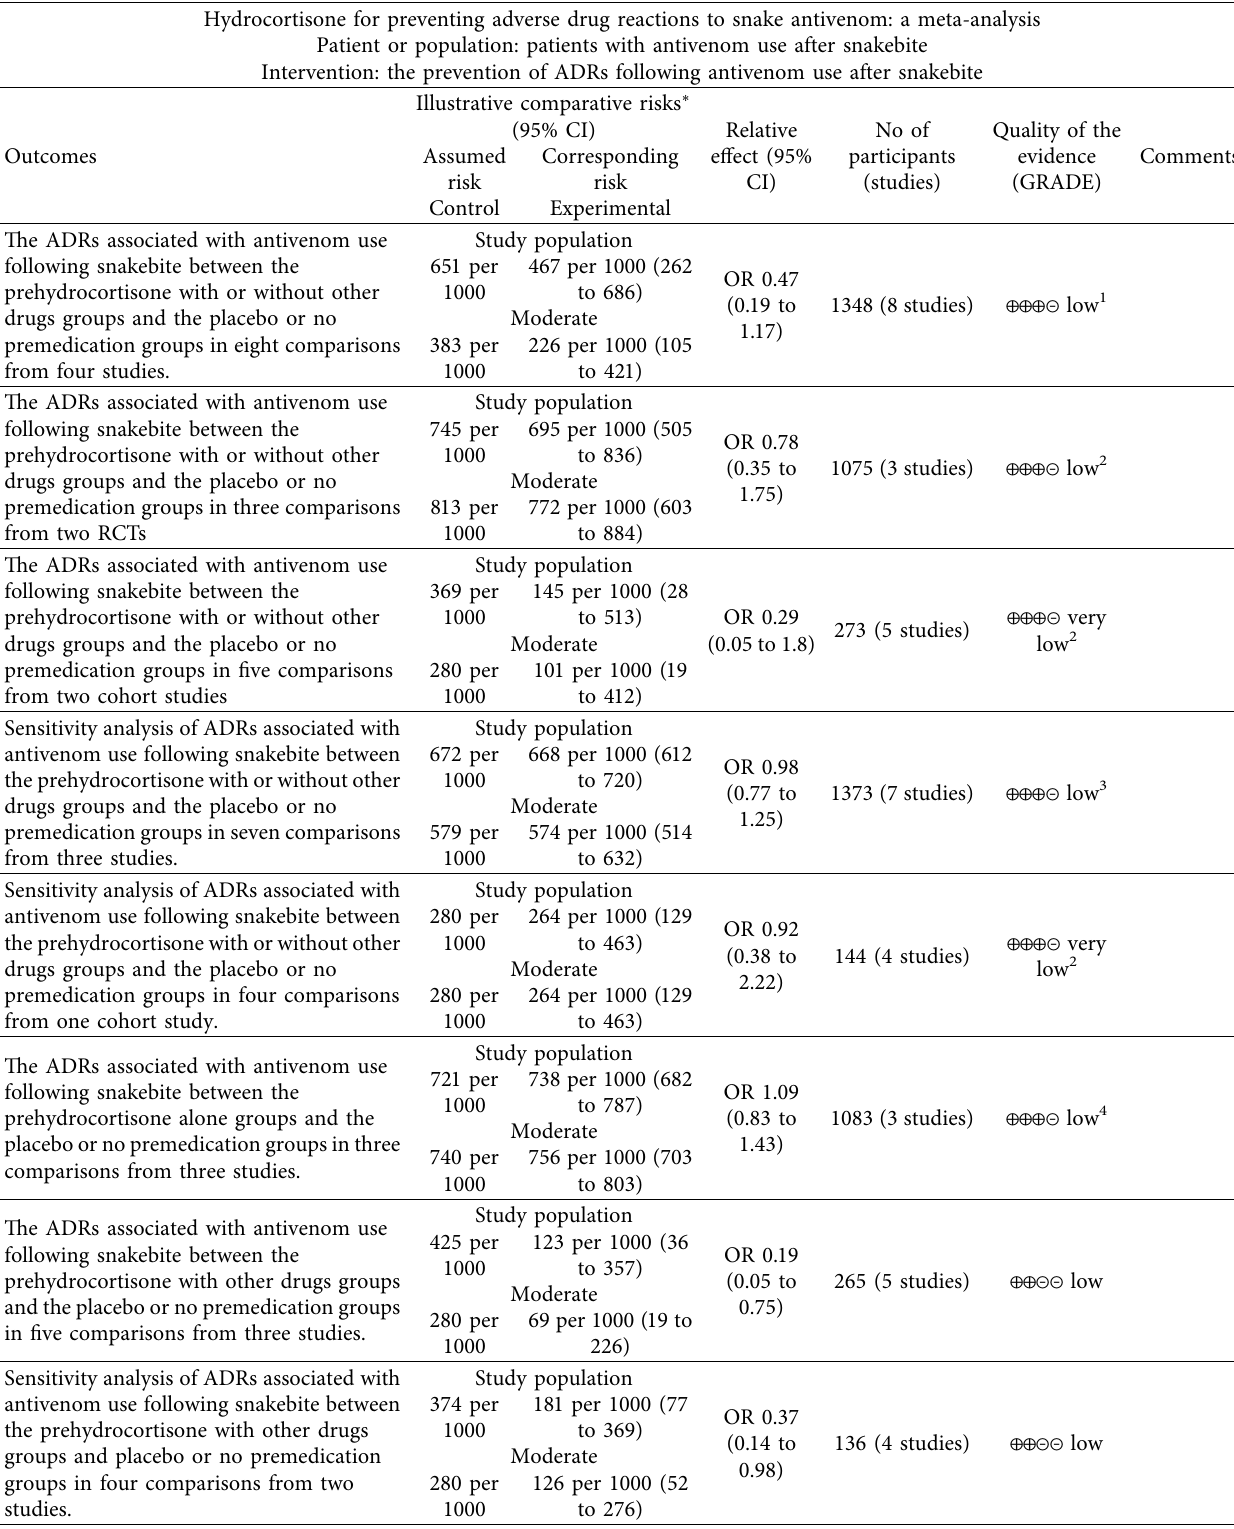
Table 2: The GRADE approach to evaluate the quality of evidence. Hydrocortisone for preventing adverse drug reactions to snake antivenom: a meta-analysis Patient or population: patients with antivenom use after snakebite Intervention: the prevention of ADRs following antivenom use after